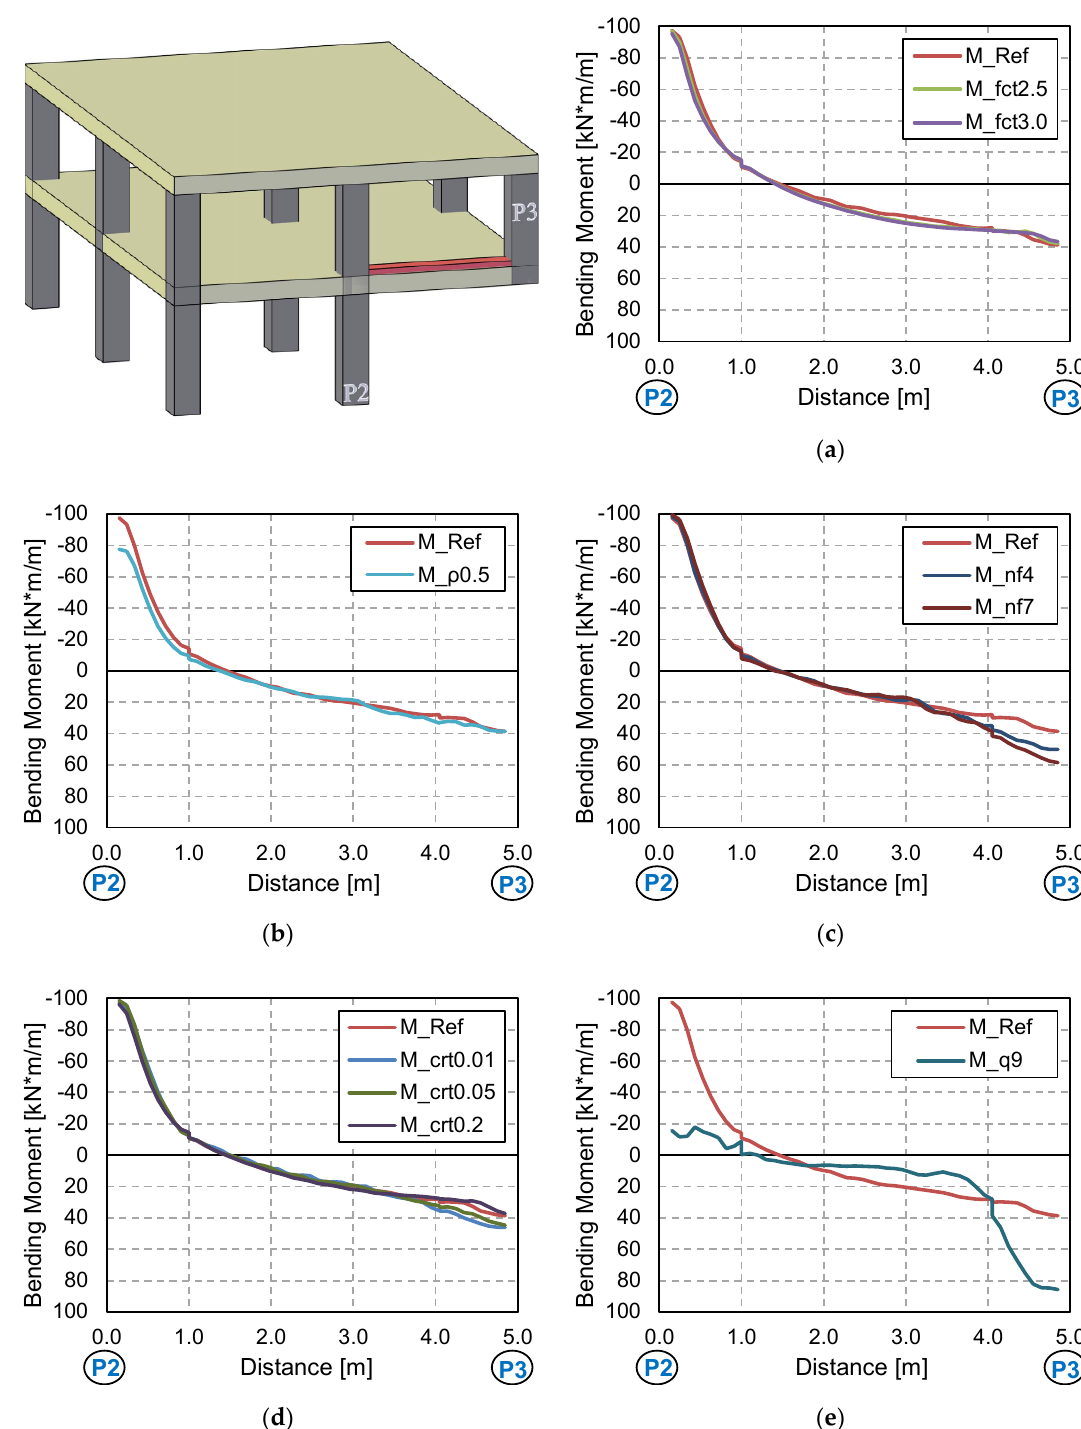
Figure 14. Influence of different parameters on bending moments from P2 to P3 in the first slab: ( a ) tensile strength, ( b ) flexural reinforcement ratio, ( c ) number of floors, ( d ) column removal time, ( e ) superimposed load.